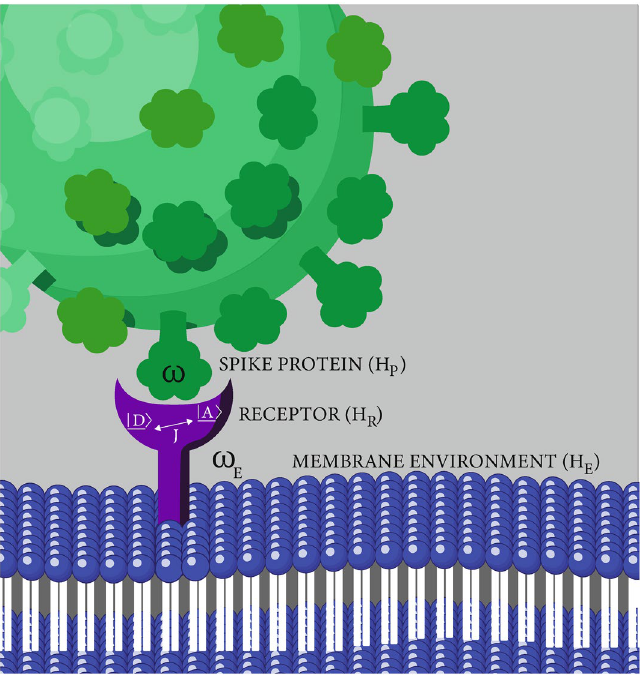
Figure 3. A simplified illustration of vibration assisted tunnelling in the context of SARS-CoV-2 infection. The spike protein vibrational spectrum matches the energy of transition for an electron in the ACE2 receptor, facilitating electron transfer and the activation of the